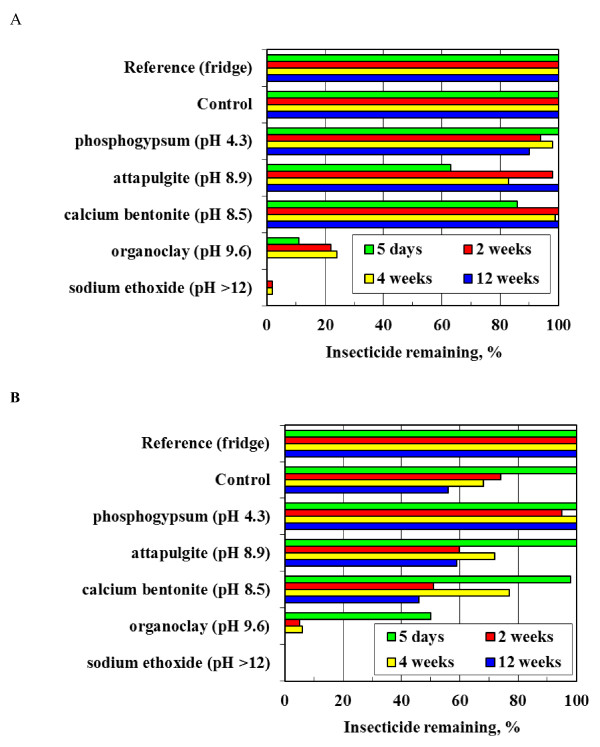
Hydrolysis rates for: A) Bendiocarb and B) Alphacypermethrin on different mineral powders and suspended in acetone containing water.